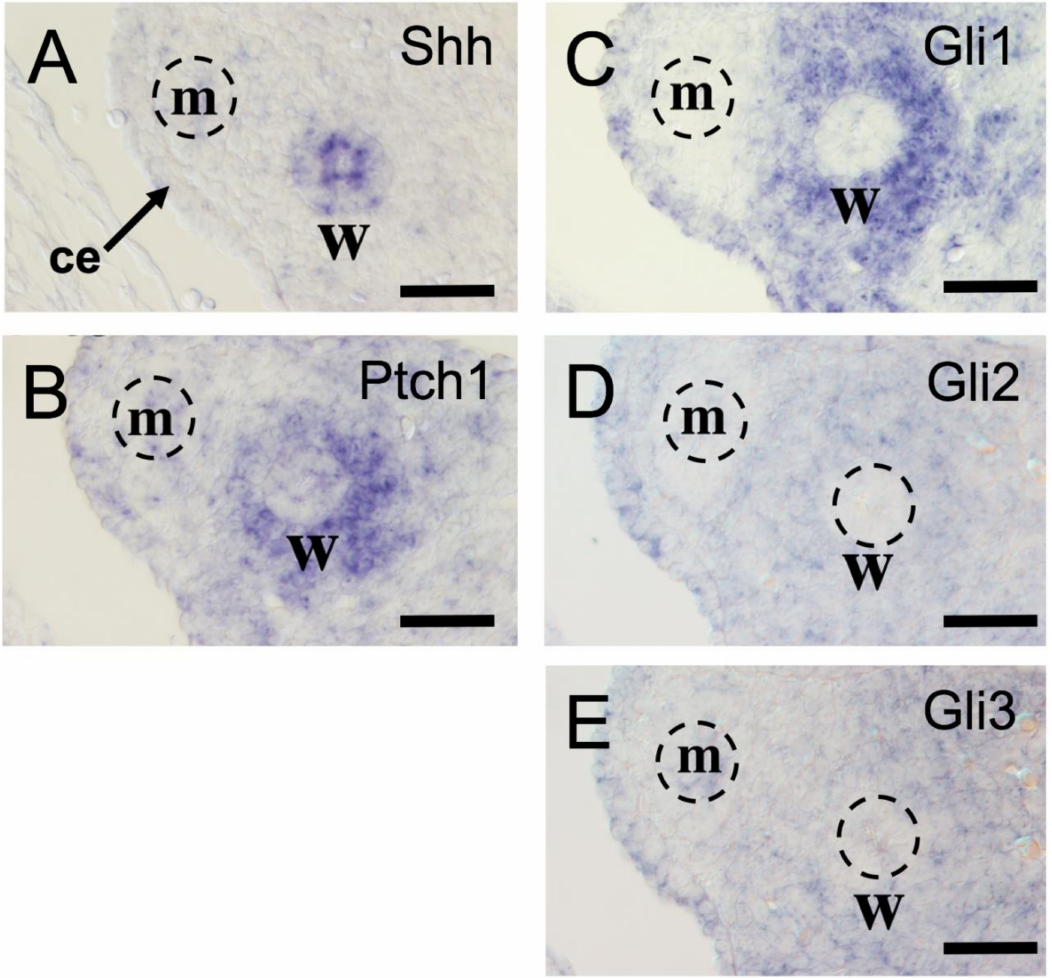
Figure 1. Expression pattern of Hh signaling genes in embryonic reproductive tracts. ( A ) At E13.5, Shh mRNA expression is observed in the Wolffian duct. ( B , C ) Ptch1 and Gli1 mRNA expression is observed specifically in the mesenchymal cells surrounding Wolffian duct. ( D , E ) Gli2 and Gli3 are weakly and diffusely expressed in the mesonephric region. Ce, coelomic epithelium; m, Mullerian duct; w, Wolffian duct. Scale bars indicate 50 µ